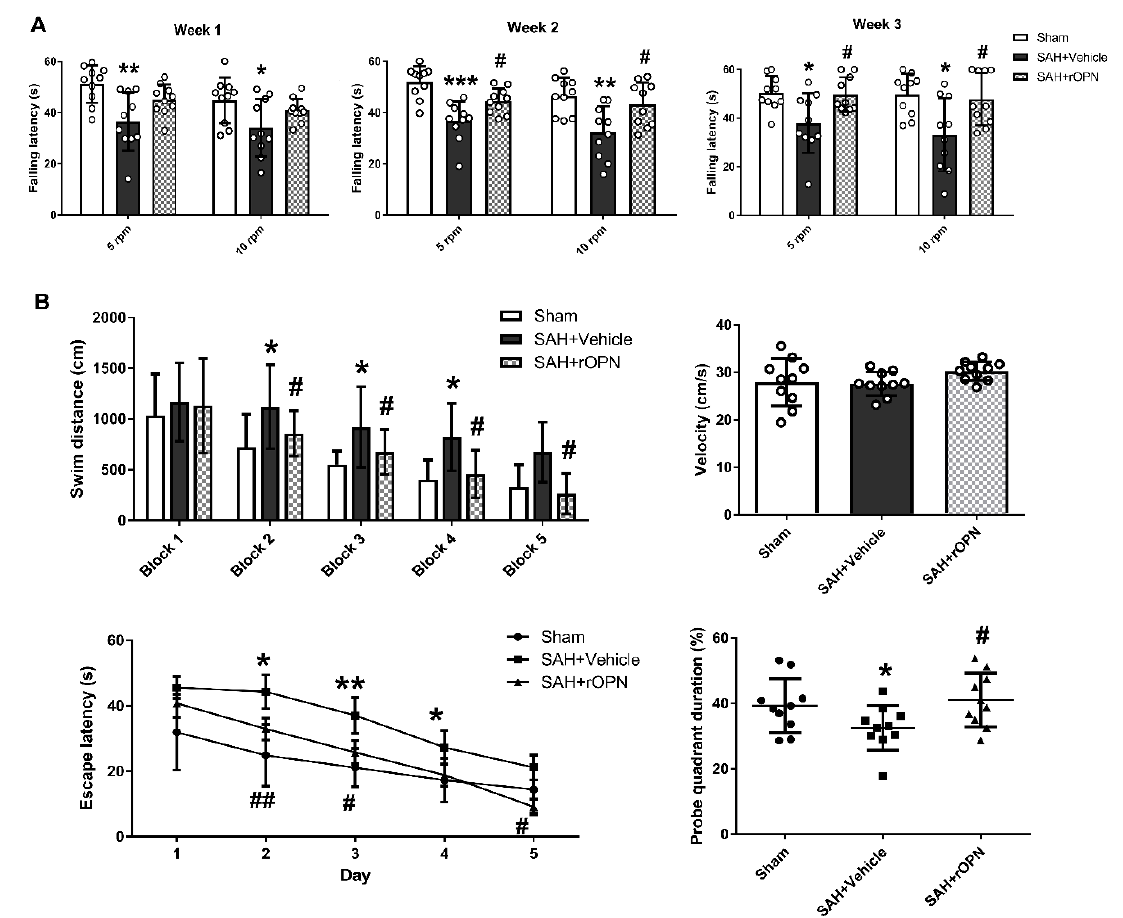
Figure 6. The effects of recombinant osteopontin (rOPN) administration on long-term neurological scores after SAH. ( A ) rOPN increased falling latency in the rotarod test by the end of second and third week after SAH. ( B ) rOPN improved water maze performance on day 22 to 26 after SAH. n = 10 per group. Data are presented as mean ± SD. * p < 0.05, ** p < 0.01, *** p < 0.001 vs. Sham group; # p < 0.05, ## p < 0.01 vs. SAH + Vehicle group. Block, daily experimental trial.